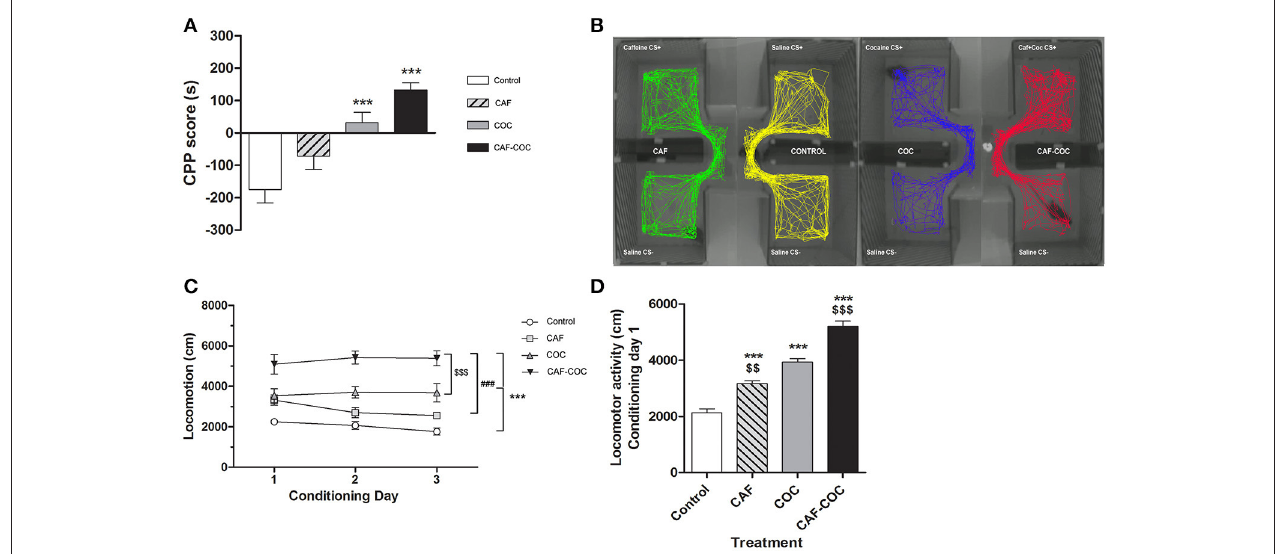
FIGURE 2 | Behavioral changes induced by caffeine, cocaine or the combination of both psychostimulants. (A) CPP score calculated as follows: CPP score (s) = time spent in the CS + chamber – time spent in the CS − chamber. Values indicate mean ± SEM. One-way ANOVA–Tukey: *** p < 0.001 different from Control. (B) Representative track plots (screen-captured from Ethovision file) of mice during CPP test. (C) Psychostimulant treatments induced locomotor activity during the conditioning phase in the CS + chamber. Two-way ANOVA with repeated measures followed by Bonferroni test, CAF-COC *** p < 0.001 different from Control,